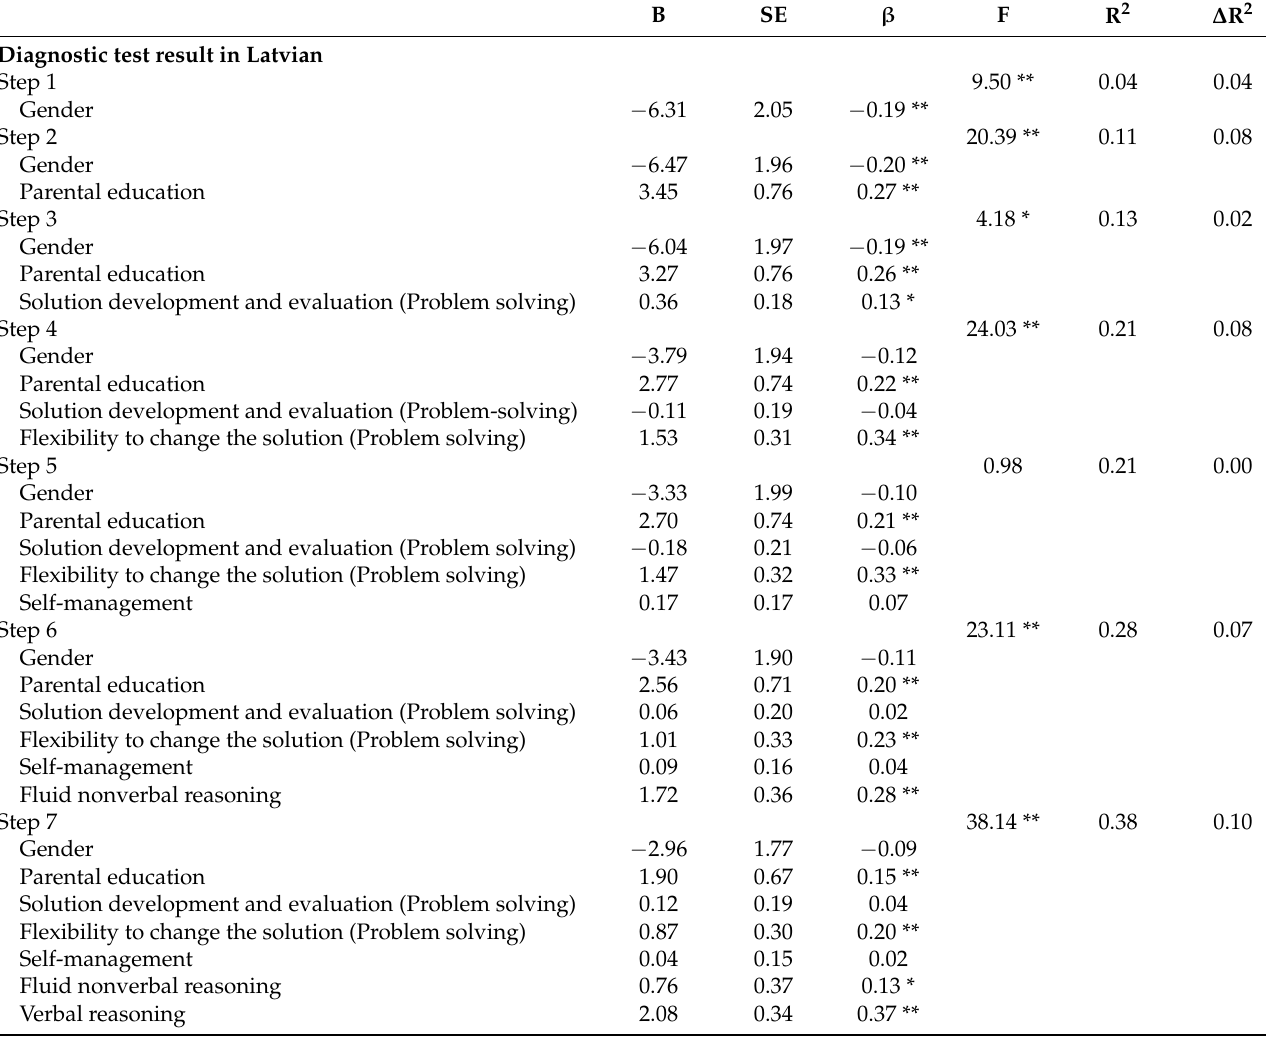
Table 4. Regression analysis of the result of the diagnostic test in Latvian ( n = 244) with independent variables: Gender, Parental education level, Solution development and evaluation and Flexibility to change the solution, Self-management, Fluid nonverbal reasoning, Verbal